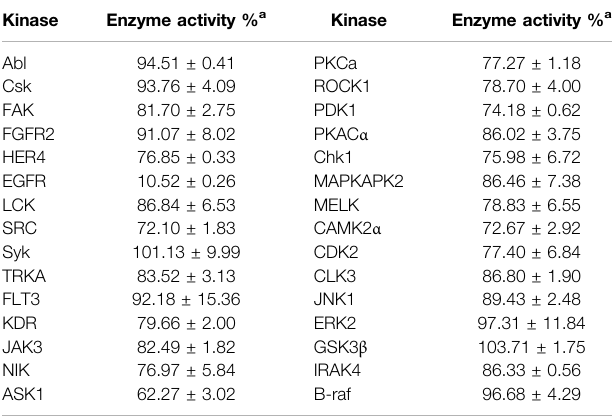
TABLE 3 | Kinase spectrum test of Compound 7i at 1 μ m. Kinase